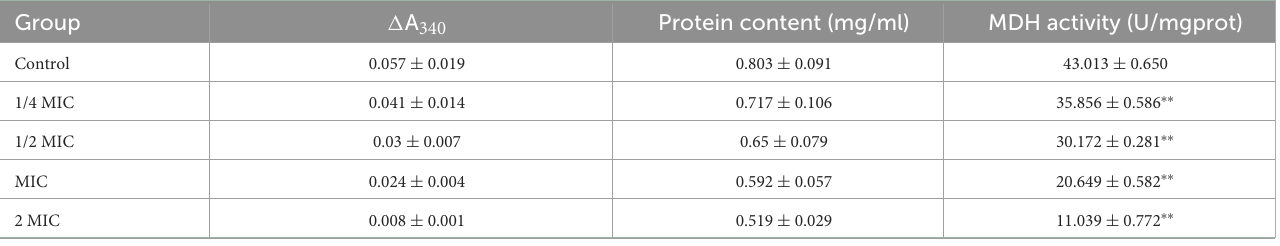
TABLE 6 Effect on MDH of bacteria treated with SEDQS.